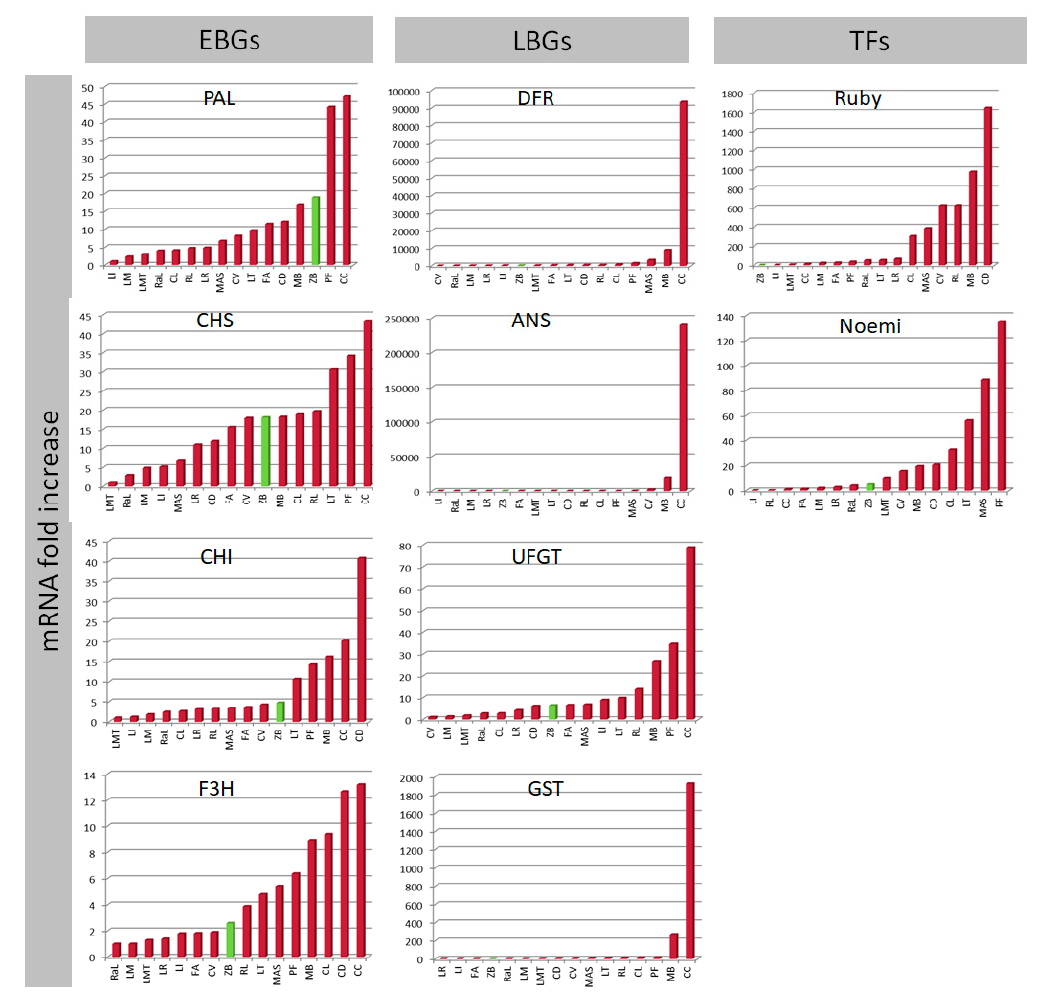
Figure 4. The qRT-PCR expression data of all structural genes: Early Biosynthetic Genes (EBGs), Late Biosynthetic Genes (LBGs) and Transcription Factors (TFs) analyzed in petals. The expression levels are calculated as the mRNA fold increase. Each accession is indicated by code: ‘Lima rossa